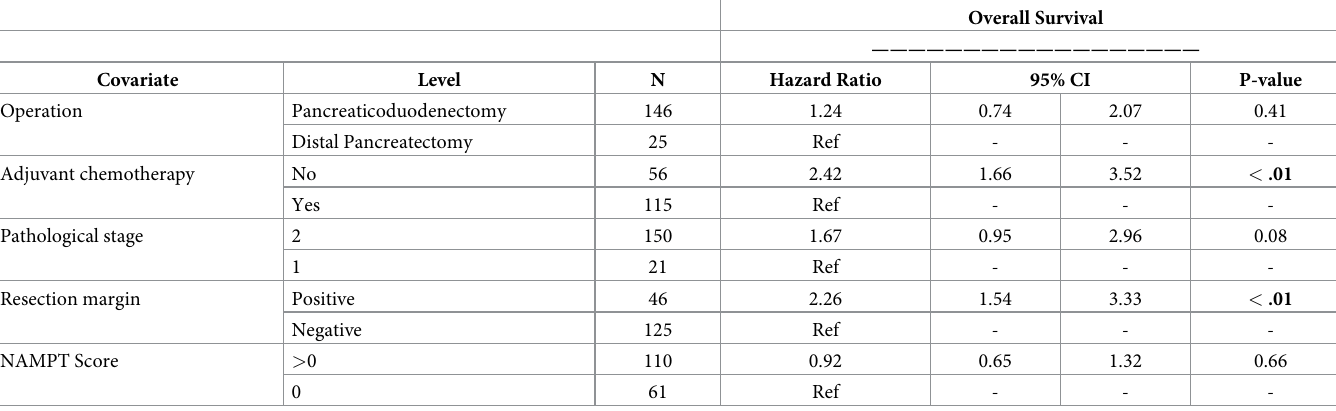
Table 6. Multivariate analysis for overall